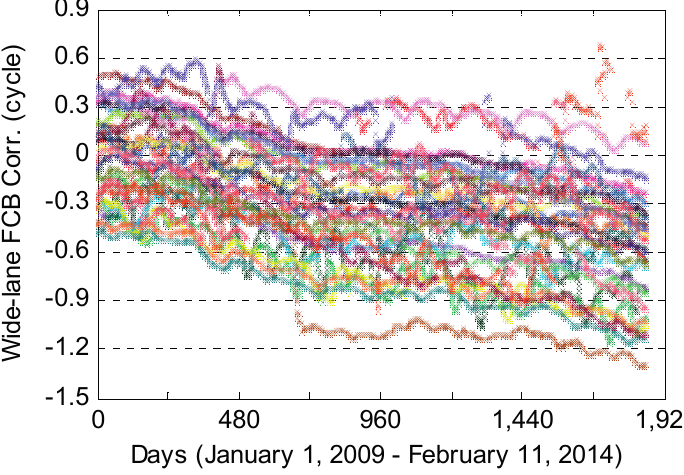
Figure 3. GPS wide-lane fractional cycle biases (FCB) corrections on the satellite end for 1863 days from 1 January 2009 to 11 February 2014.